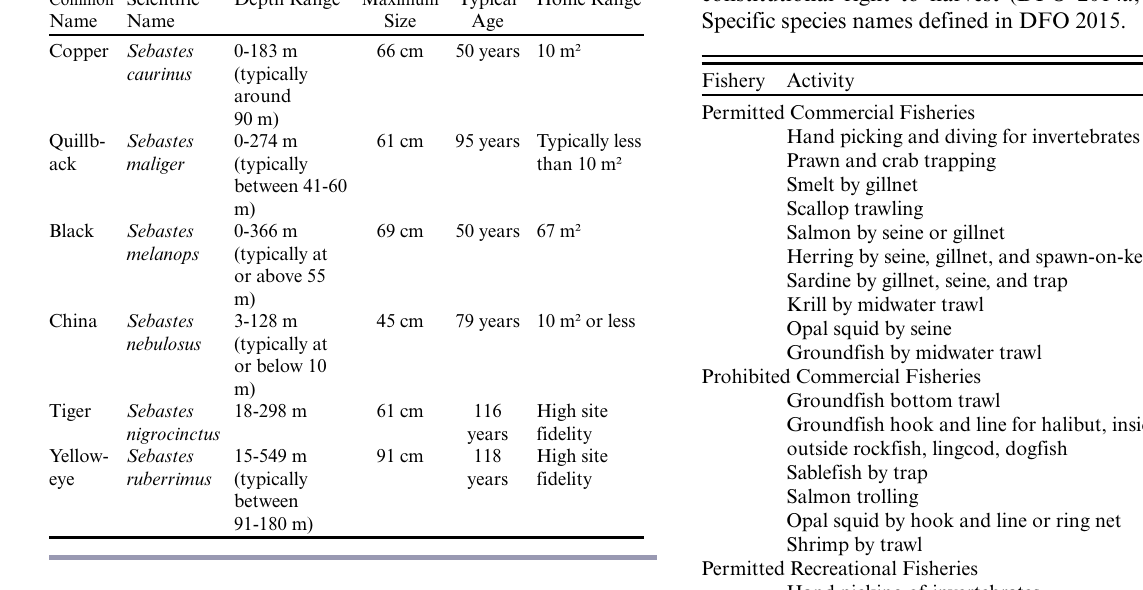
Table 2 . Permitted and prohibited commercial and recreational fishing activities within Rockfish Conservation Areas (RCAs). Aboriginal fisheries are not included in the table because their fishing activities are unrestricted within RCAs on account of their constitutional right to harvest (DFO 2014 a , Haggarty